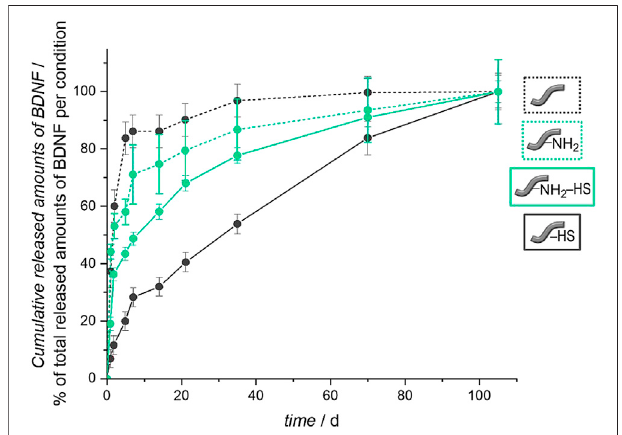
FIGURE 10 | Relative BDNF release curves for unmodi fi ed and amino- modi fi ed fi bers,carryingheparansulfateornot.Thetotalamountreleasedwas set to 100% for each